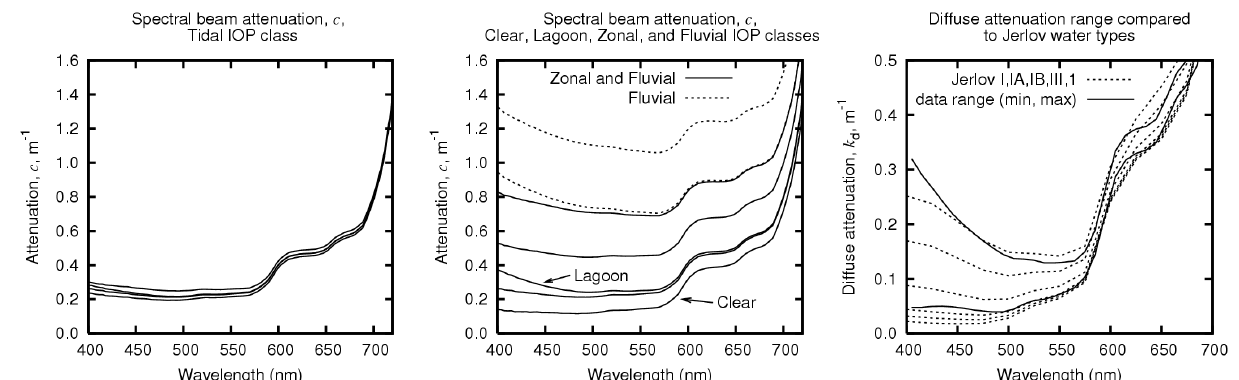
Figure 5. Optical properties of IOP datasets used in the IOP class definitions. ( Left ): total spectral beam attenuation of Tidal class comprising four datasets sampled at approximately 2 h intervals showing tidal variation on a fore-reef site. ( Centre ): Clear and Lagoon classes are each represented by single dataset. The Zonal class contains both Clear and Lagoon datasets and three others from lagoonal and fore-reef locations. The Fluvial class contains all the datasets of the Zonal class plus two others taken in proximity to a river outflow. ( Right ): modelled diffuse attenuation k (solar zenith angle 15°, over 5 m depth with live d coral substrate) of the clearest and most turbid IOP datasets compared to Jerlov water types I, IA, IB, II, III and 1 (from bottom to top